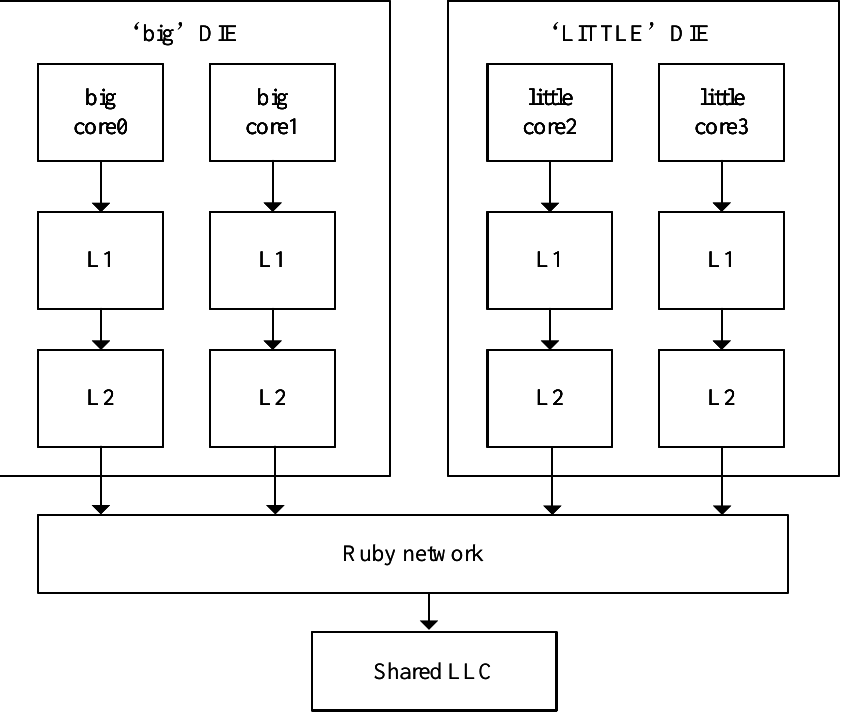
Figure 3. System architecture of